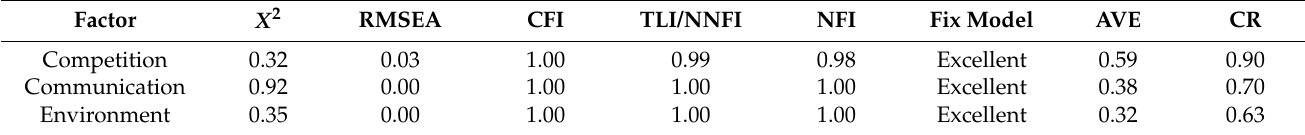
Table 1. CFA, AVE, and CR of the evaluation instrument